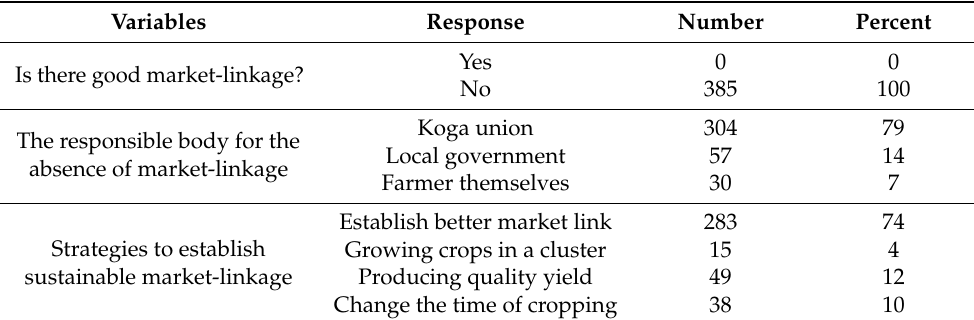
Table 9. The market-linkage problem as perceived by